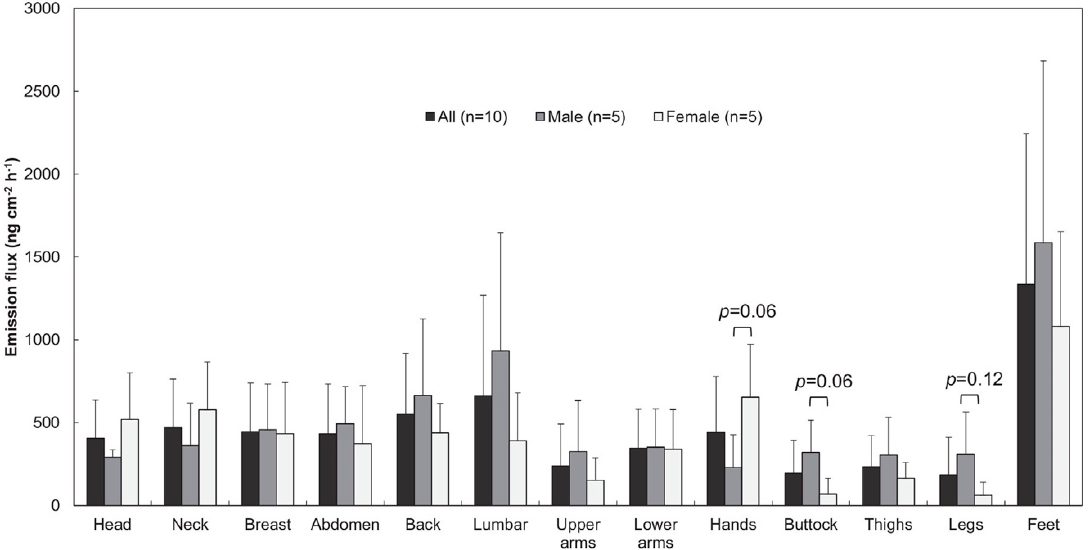
Figure 4. Comparison of emission flux of ammonia emanating from 13 sampling positions of ten volunteers. Error bars show standard deviation of measured values of tested volunteers ( n = 10 for all, n = 5 for male, and n = 5 for female volunteers). Reproduced from [74], with permission from Elsevier, 2019.